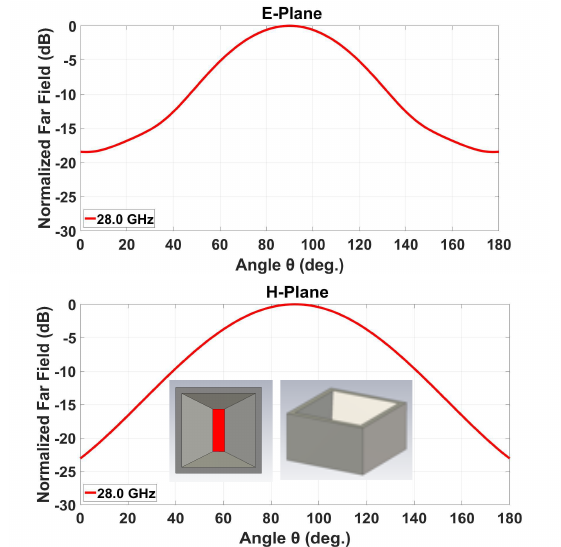
Figure 4. Simulated radiation patterns of single ordinary horn element (without pair of metal chips) in both principal planes: ( top ) E-plane perpendicular to slot alignment; and ( bottom ) H-plane parallel to slot alignment. Horn schematics (two views) are shown as inset diagrams.